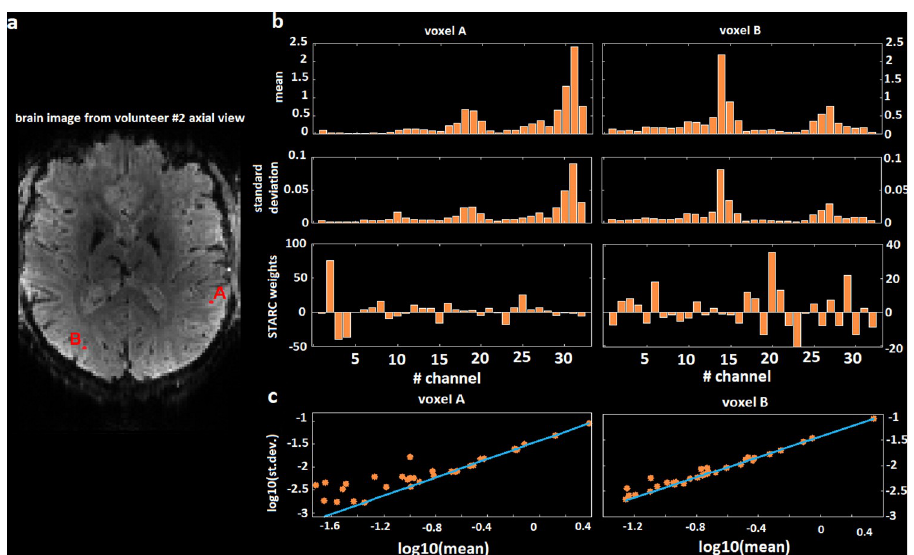
Fig 5. Weights distributions from STARC optimization for two voxels. a–Brain image from volunteer #2 axial view, the red points labelled A and B are the voxels whose weights are analysed. b–For both voxels A and B, the bar plots display the temporal mean, the temporal standard deviation and the optimized STARC weights. The channels receiving the strongest signal have the highest variability but will be given the lowest weight. c–Scatter plot of the mean versus the standard deviation for each channel, the slope of the linear fit of the ten strongest channels is also plotted. The signal variability is highly proportional to the signal strength.